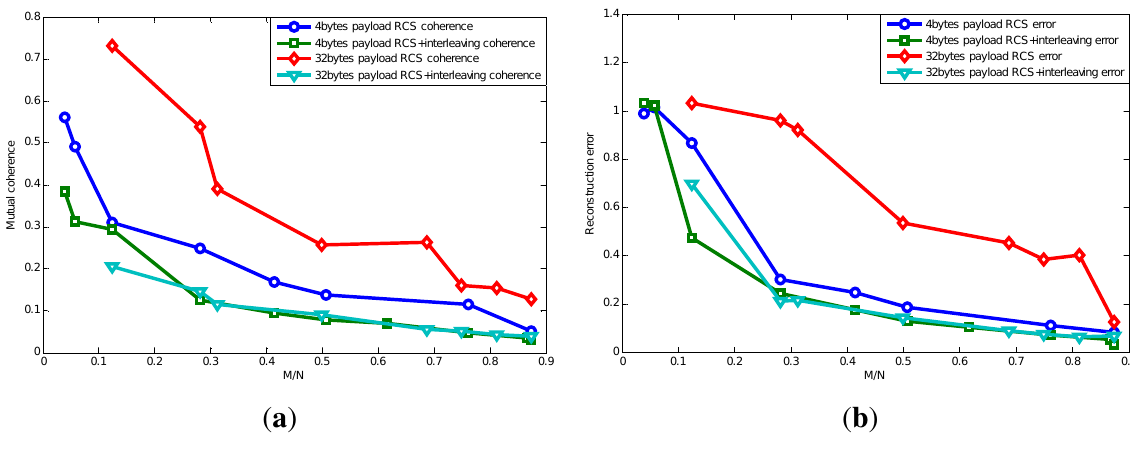
Figure 24. Interleaving improvement with different packet lengths. ( a ) Interleaving improvement on mutual coherence with different packet lengths; ( b ) interleaving improvement on recovery error with different packet